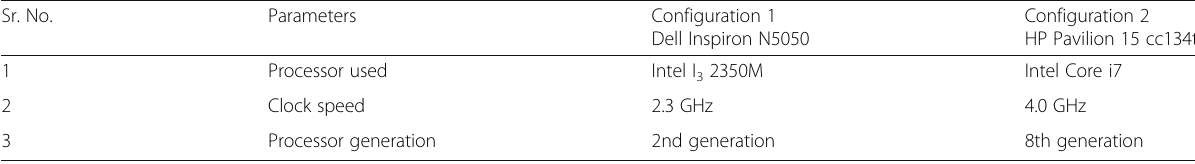
Table 4 Comparison between two configurations Sr. No.